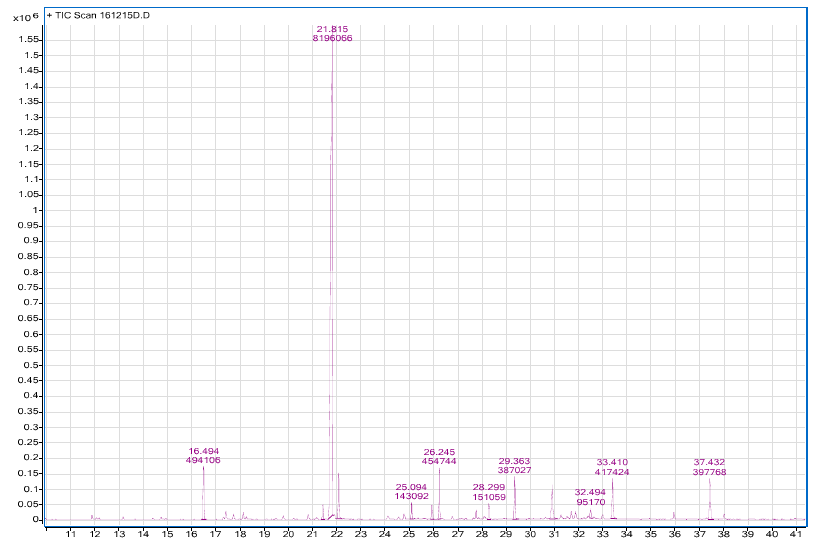
Figure 3. Chromatogram of gas chromatography analysis of Achillea odorata subsp. pectinata essential oil.